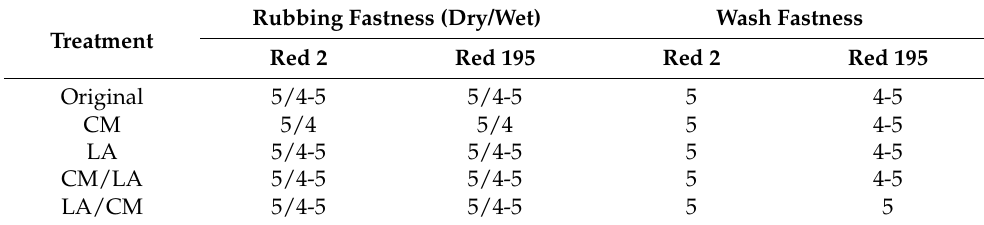
Table 4. Rubbing and washing colorfastness (staining)